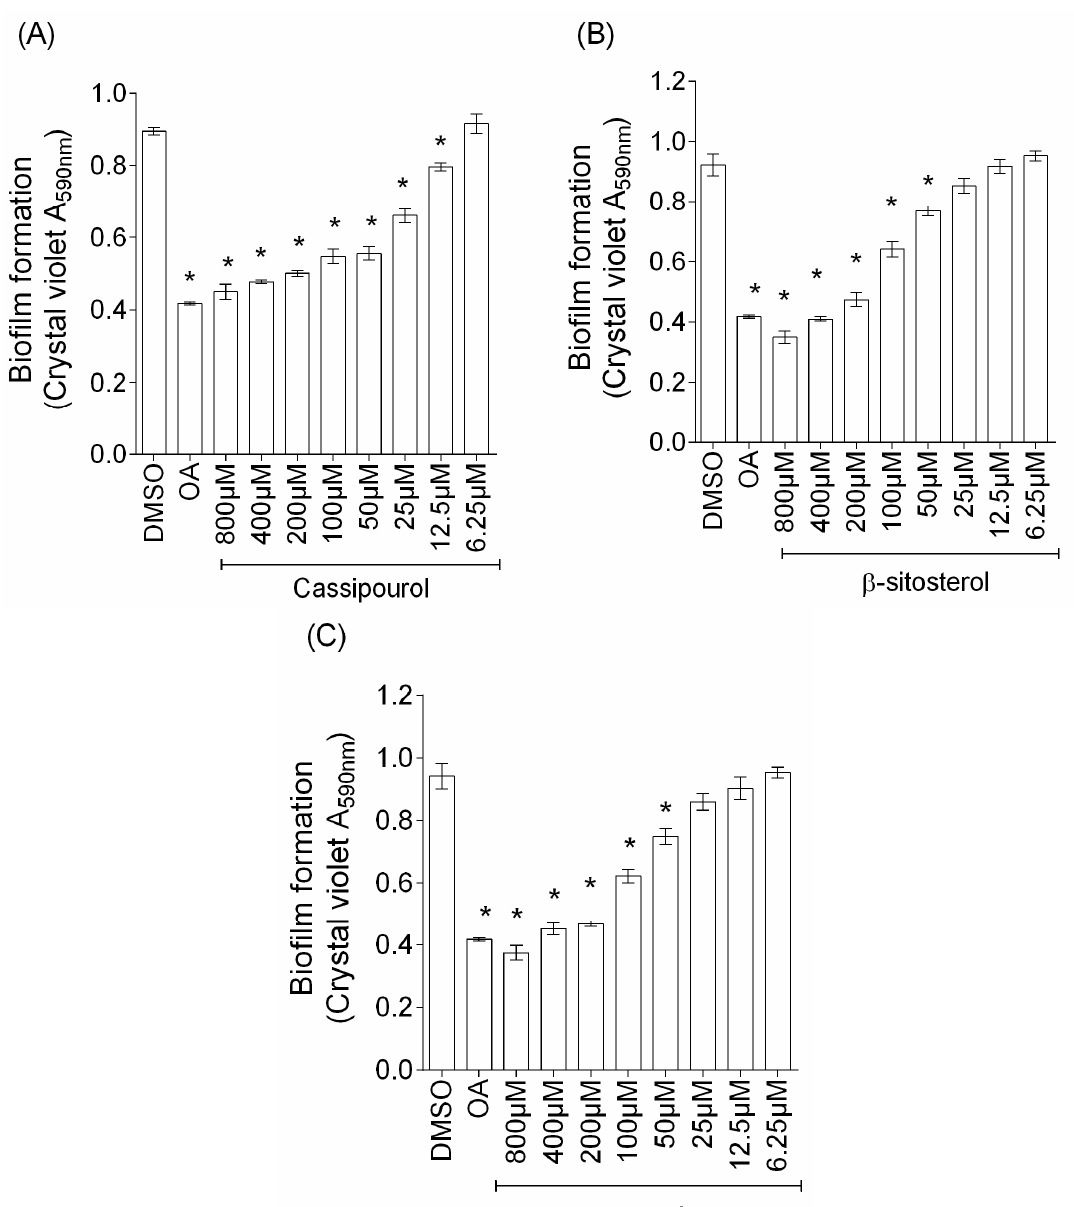
Figure 6. Dose-dependent anti-biofilm activity of: cassipourol ( A ); β -sitosterol ( B ); and α -amyrin ( C ). The biofilm formation of P. aeruginosa PAO1 grown in minimal medium supplemented with DMSO 1%, oleanolic acid 800 µM (OA) or different concentrations of purified compounds (from 6.25 to 800 µM) after incubation without agitation at 37 °C for 24 h. Biofilm formation was quantified by crystal violet staining and measured as A 590nm . All experiments were performed in triplicate with three independent assays. Error bars represent the standard errors of the means; all experiments were performed in quintuplicate with three independent assays and asterisks indicate samples that are significantly different from the DMSO (One-way ANOVA followed by Dunnett’s test of multiple comparisons; p < 0.01).